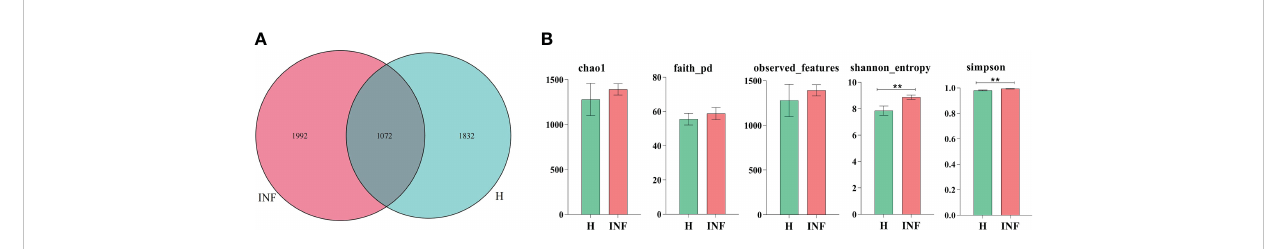
FIGURE 1 ASV venn map and Alpha diversity index analysis. (A) Venn map, (B) Alpha diversity index. ** refers to signi fi cance level, p <0.05.